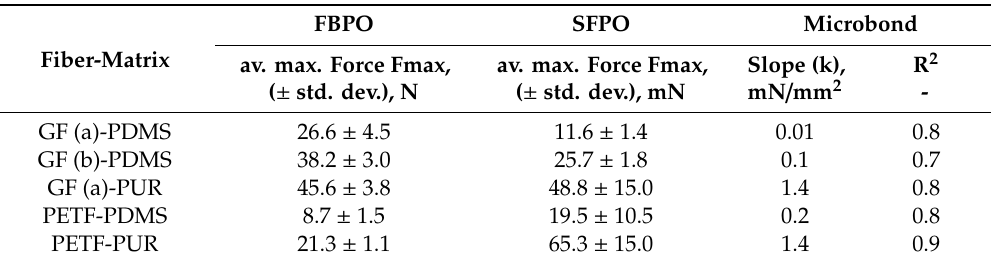
Table 2. Results for FBPO-SPFO and microbond test for different fiber-matrix combinations.